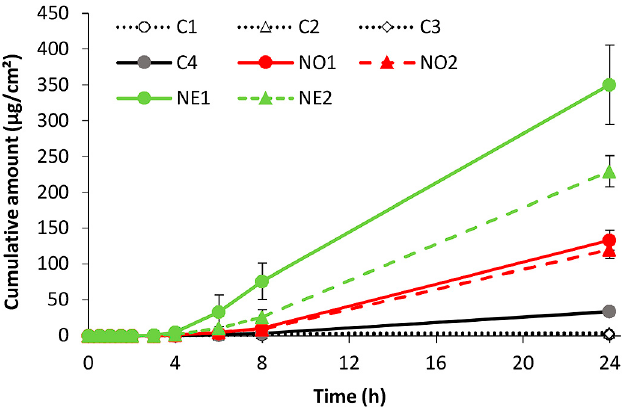
Figure 1. Cumulative amount of minoxidil permeating through full-thickness human skin from nanoemulsions and control vehicles (mean ± SD, n = 4).